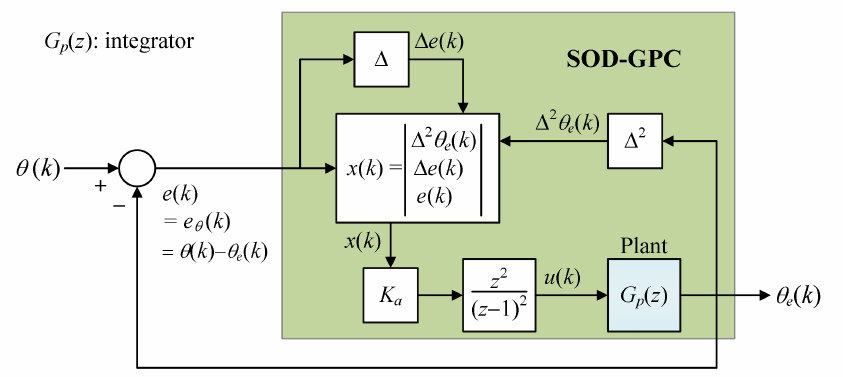
Figure 5. Simplified block diagram of the proposed ATO considering only the effect of e θ ( k ) in the angle estimation.